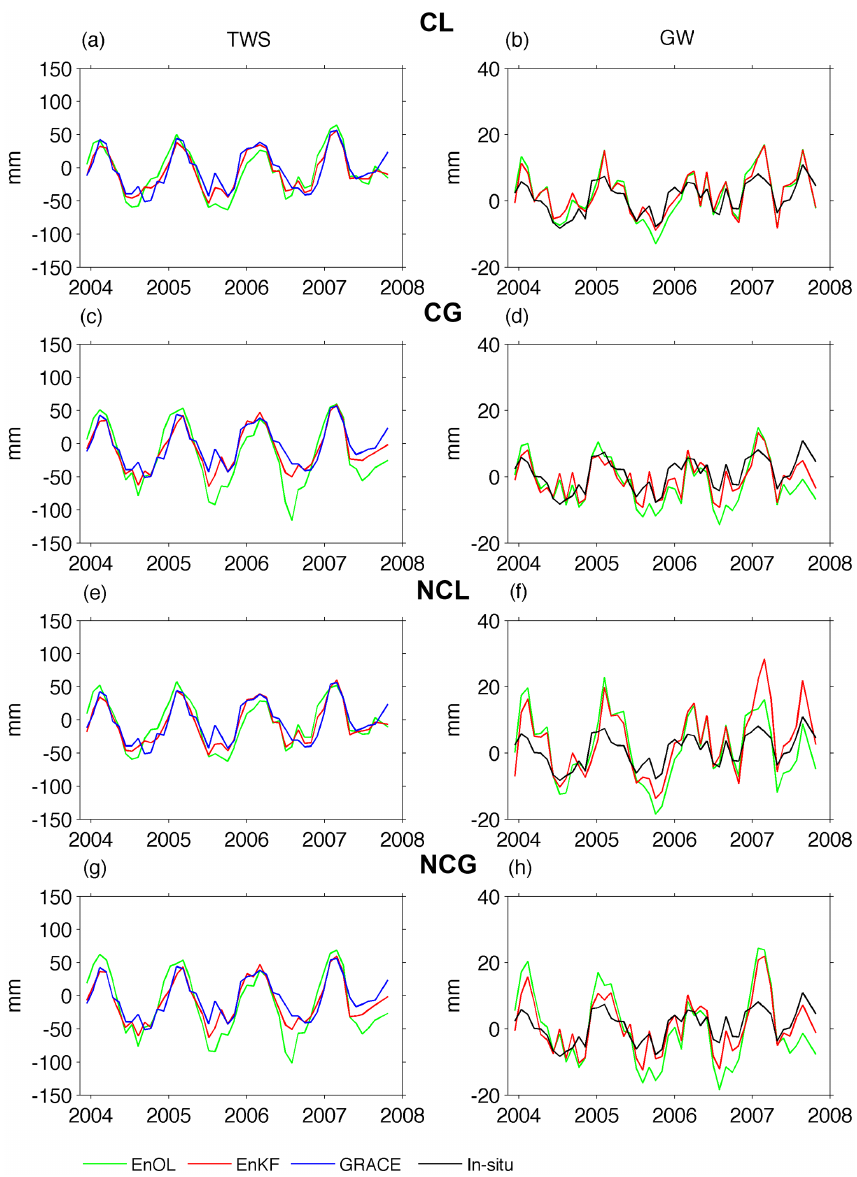
Figure 7. TWS variation (left panels) and GW variation (right panels) at the Sundern well location in four different scenarios (CL: calibrated parameters with local forcing data; CG: calibrated parameters with global forcing data; NCL: non-calibrated parameters with local forcing data; NCG: non-calibrated parameters with global forcing